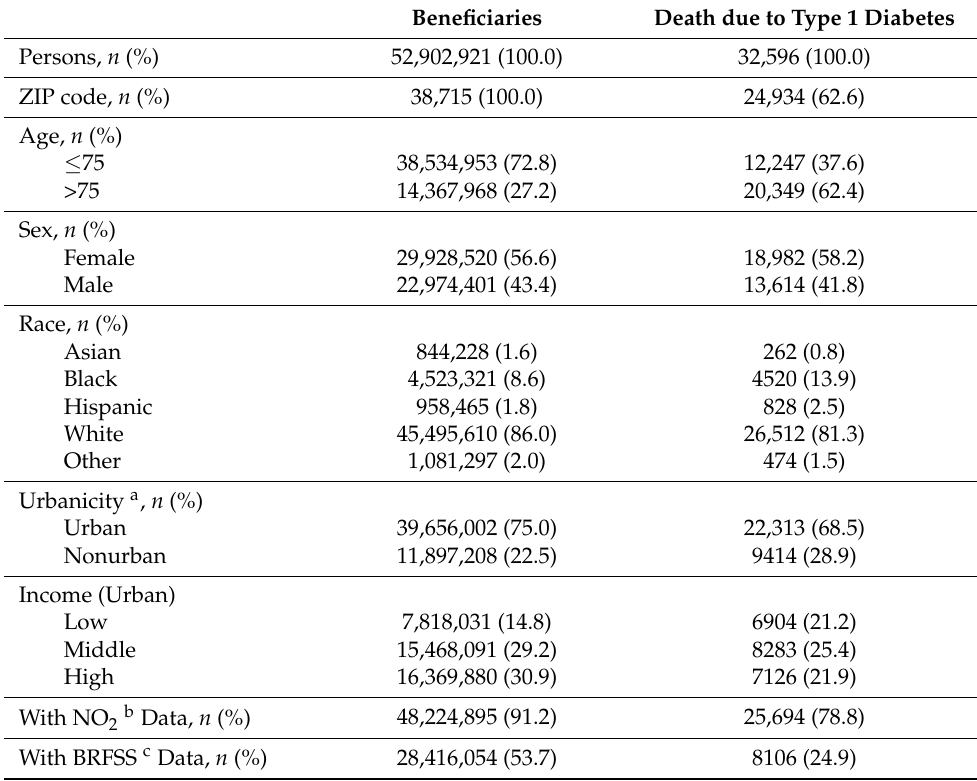
Table 1. Baseline demographics for Medicare beneficiaries and death time demographics for diabetes- related